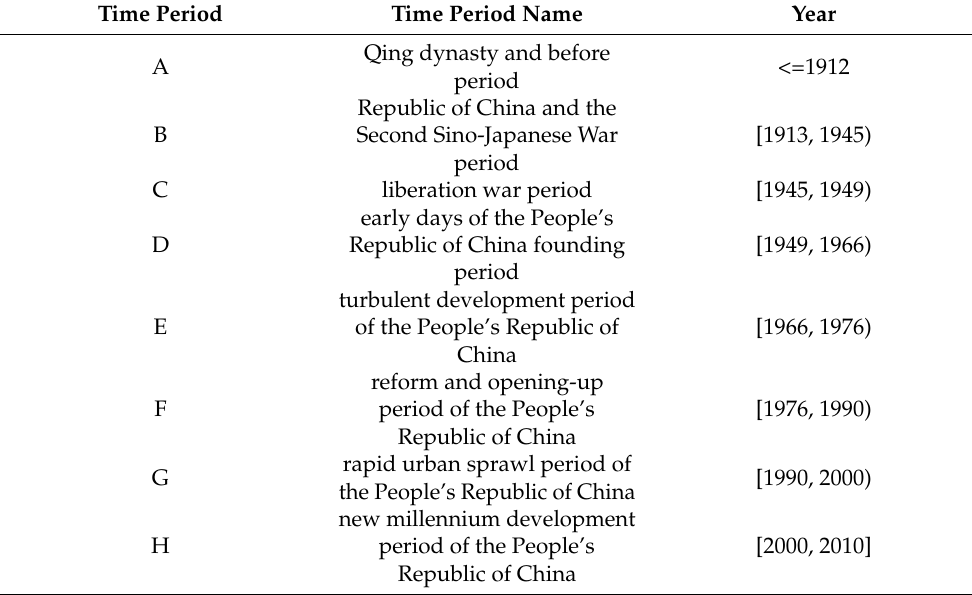
Table 1. Time periods of the street naming